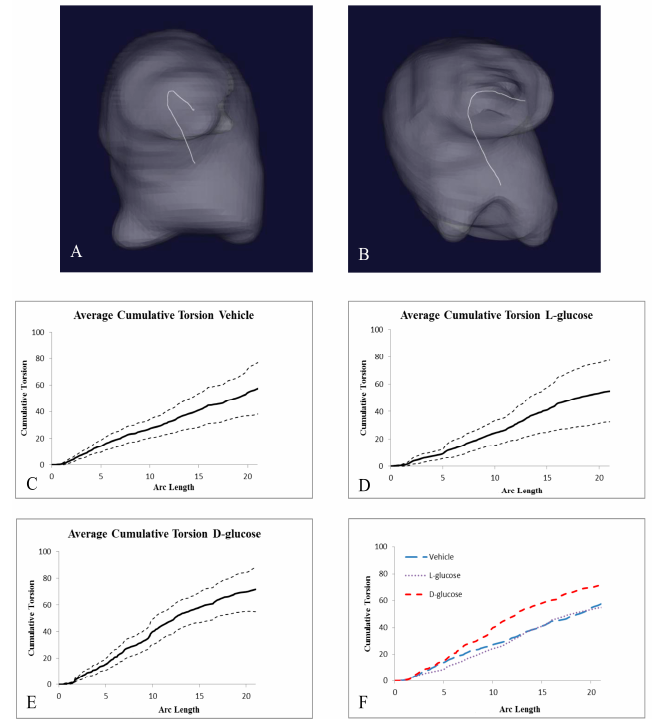
Figure 5. Hyperglycemic conditions can result in changes in the torsion of the OFT. 3D centerlines of a HH24 representative ( A ) vehicle control embryo and ( B ) D -glucose-treated embryo to quantify the amount of torsion of the OFT. ( C – E ) Graphs, separated by treatment, of the average cumulative torsion, with the dashed lines representing + and − 1 standard deviations of the OFT torsion plotted against the cumulative arc length. ( F ) The average cumulative torsion of the three treatments plotted against the average arc